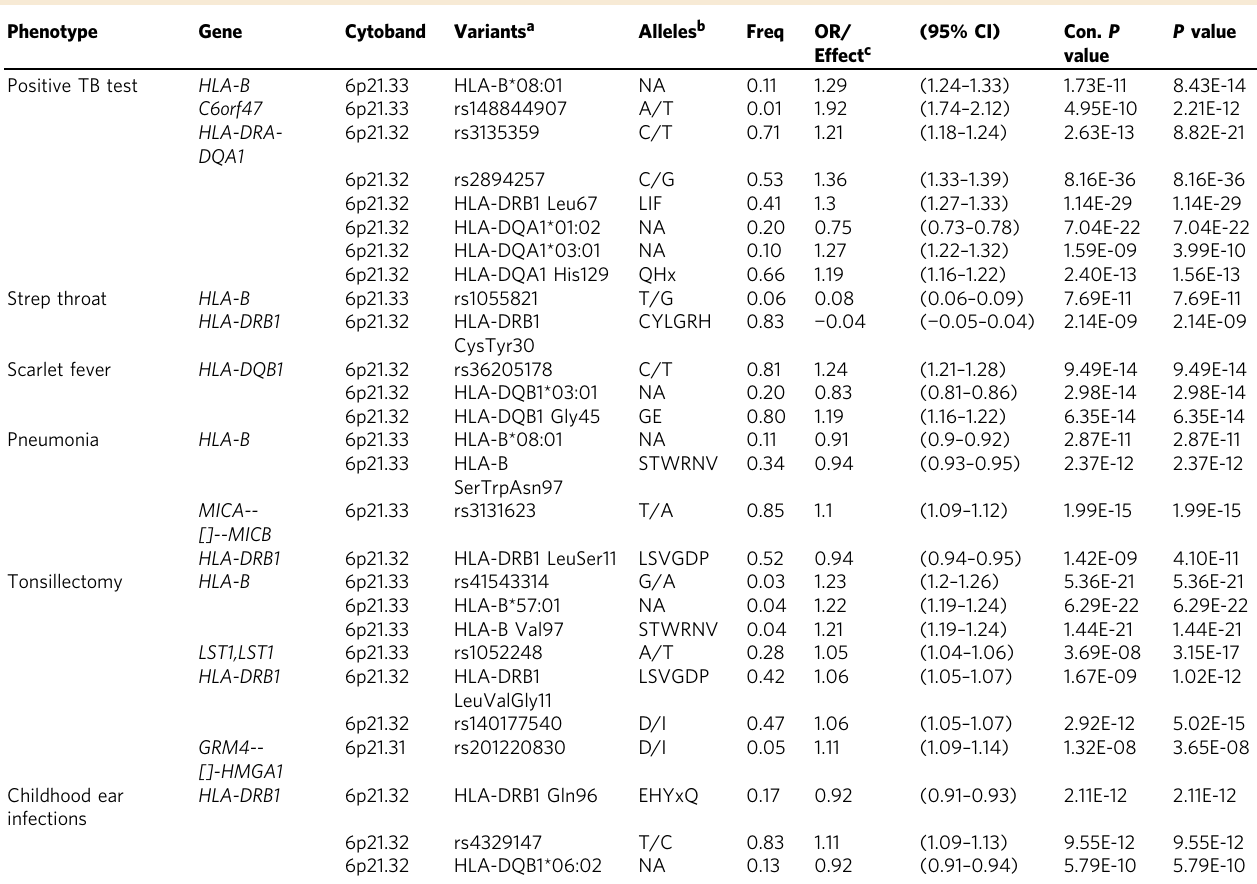
Table 5 HLA fi ne-mapping results for each disease part